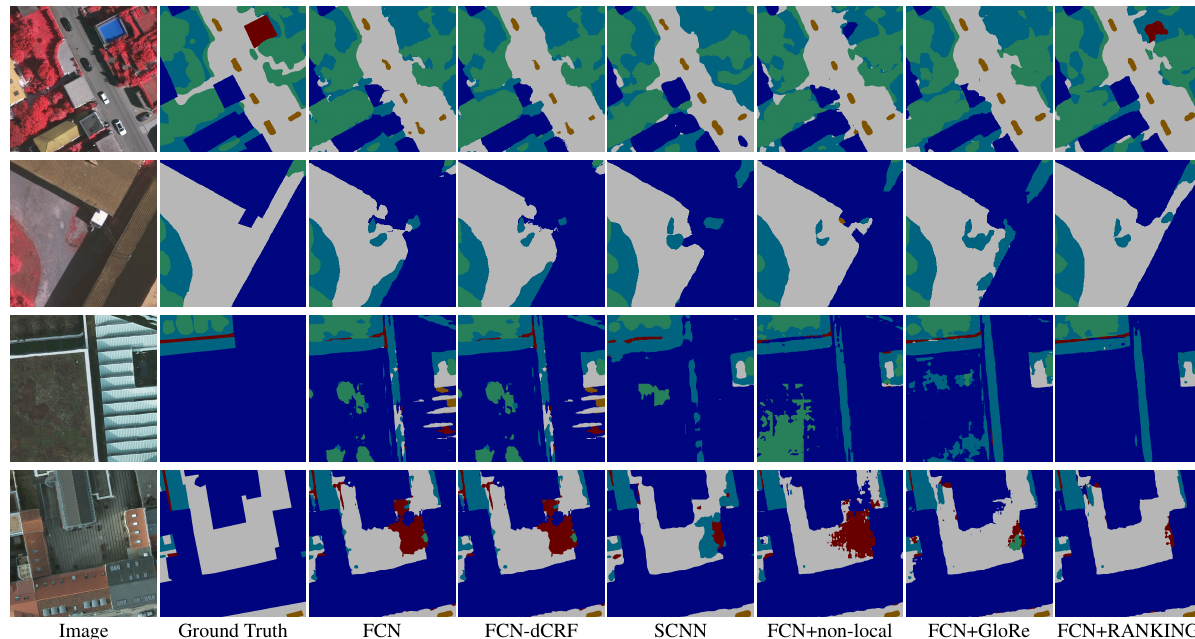
Figure 4. Examples of segmentation results on the Vaihingen (top two rows) and Potsdam (bottom two rows) dataset. Legend—gray: impervious surfaces, blue: buildings, cyan: low vegetation, green: trees, brown: cars, and red: clutter/background. Table 4. Numerical Results on the Potsdam